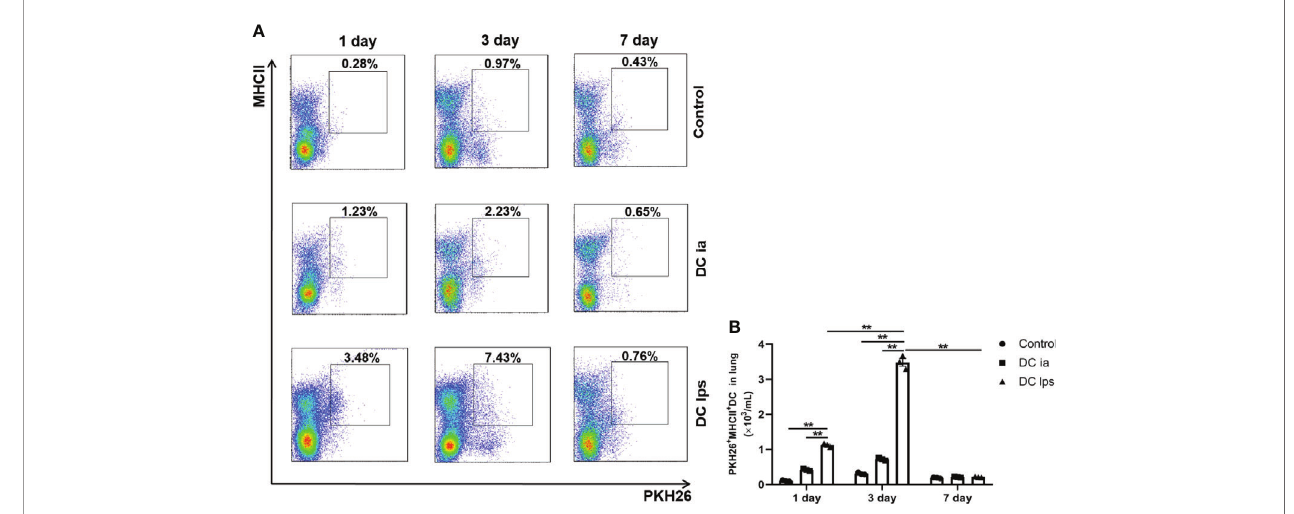
FIGURE 3 | Adoptive transfer of DClps effectively migrated to the lung of OVA-induced asthmatic mice. (A) The transferred DCs were stain with PKH26 fl uorescent dye. Representative FCM dot plots of PKH26 + MHCII + DC on days 1, 3 and 7 are shown. (B) Numbers of PKH26 + MHCII + DC in the total lung mononuclear cells. The columns and error bars represent the mean and SEM. (**P < 0.01, ANOVA with Tukey ’ s post hoc analysis). The same experiment was repeated three times with similar results (n = 3 in each